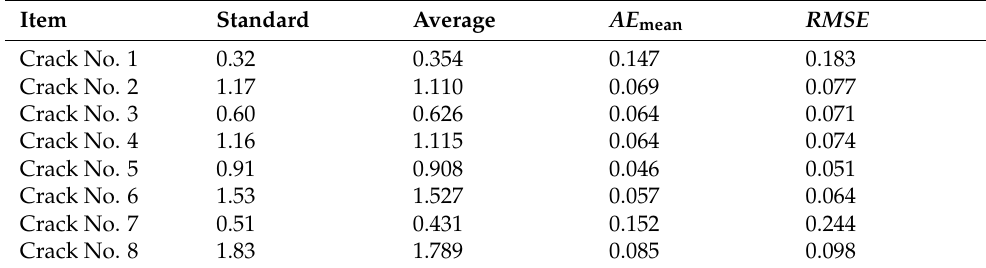
Table 5. Evaluation of the 12 crack width values between measured in 20 images and real values